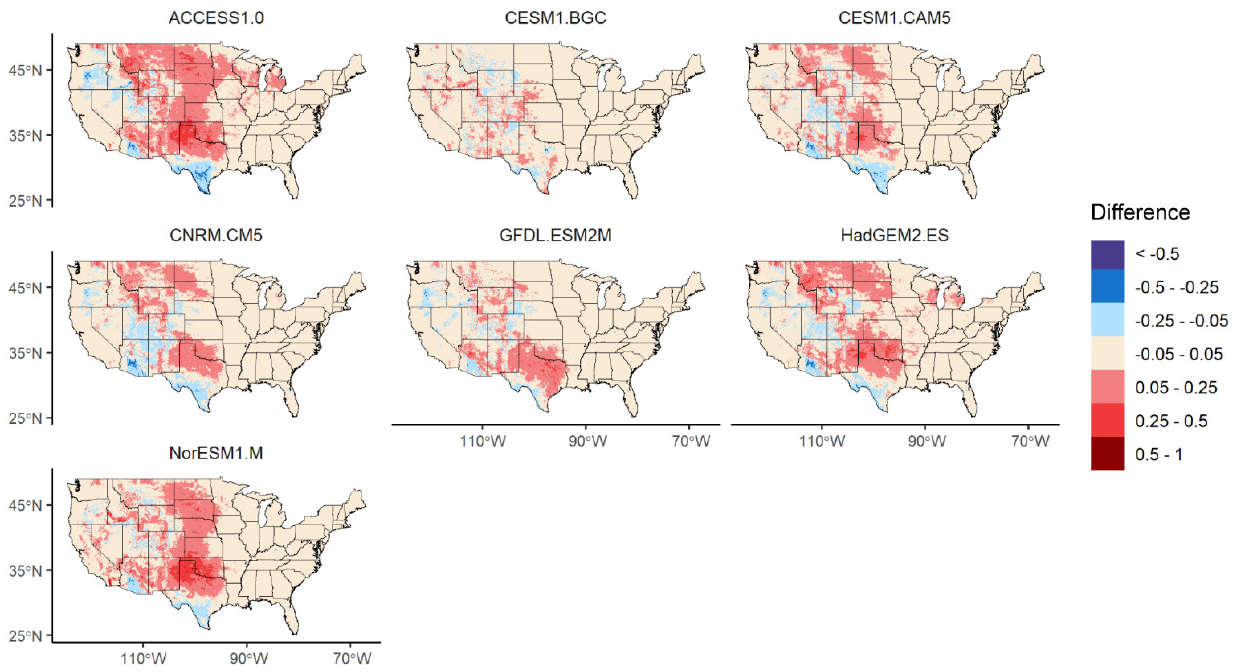
Figure 7. As Figure 5, except using climate projections from the RCP 8.5 emission scenario. However, RCP 8.5 MaxEnt results indicate low agreement in predicted ROR along the eastern extent of the VS current range in Texas, Oklahoma, Kansas, Nebraska, and South Dakota (Figure 8a). We also note that there is much more disagreement in our RCP 8.5 MaxEnt results compared to our RCP 4.5 results (Figure 6a,b and Figure